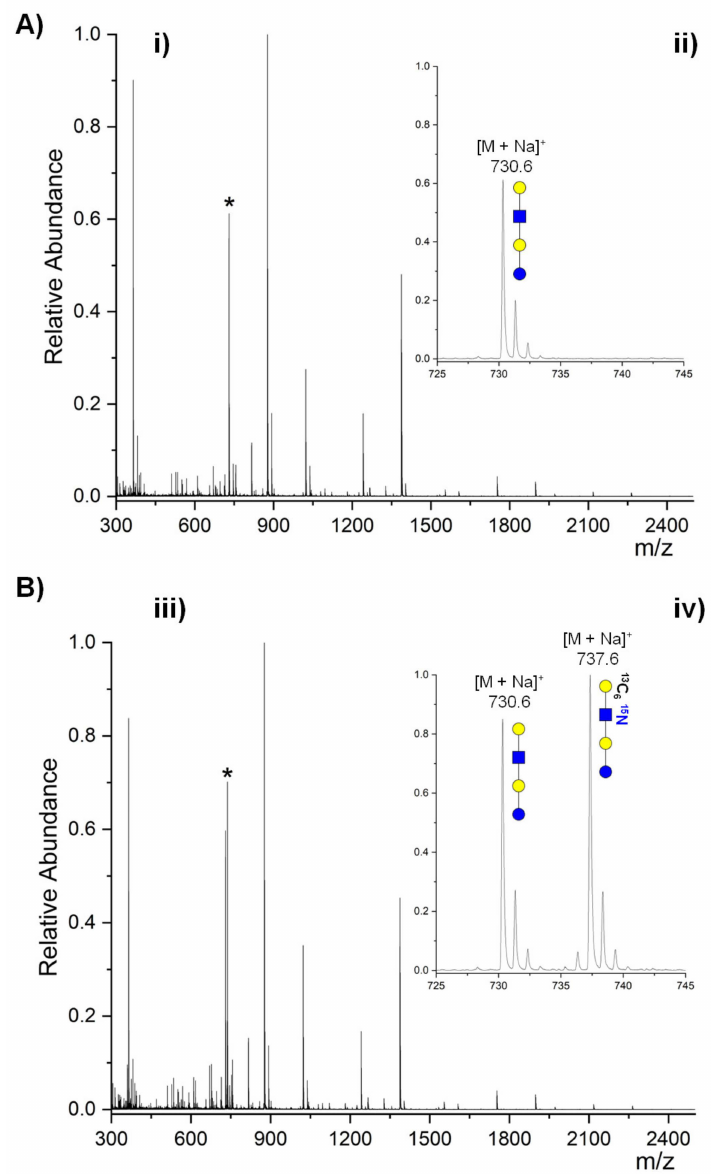
Figure 3. ( A ) MALDI-TOF mass spectrum of PGC-SPE extracted human milk in the m / z range from 300 to 2500 ( i ) and the magnified m / z range from 726 to 746 ( ii ). An asterisk indicates the signal corresponding to tetraose ( m / z = 730.6204 [M + Na] + ). ( B ) MALDI-TOF mass spectrum from PGC-SPE extracted human milk spiked with [ 13 C 6 / 15 N]LNnT. An asterisk in the in the m / z range from 300 to 2500 ( iii ) indicates the signals corresponding to tetraose ( m / z = 730.6204 [M + Na] + and [ 13 C 6 / 15 N] LNnT (737.641 [M + Na] + ). The two isotopologues are highlighted in the amplified m / z range from 726 to 746 ( iv